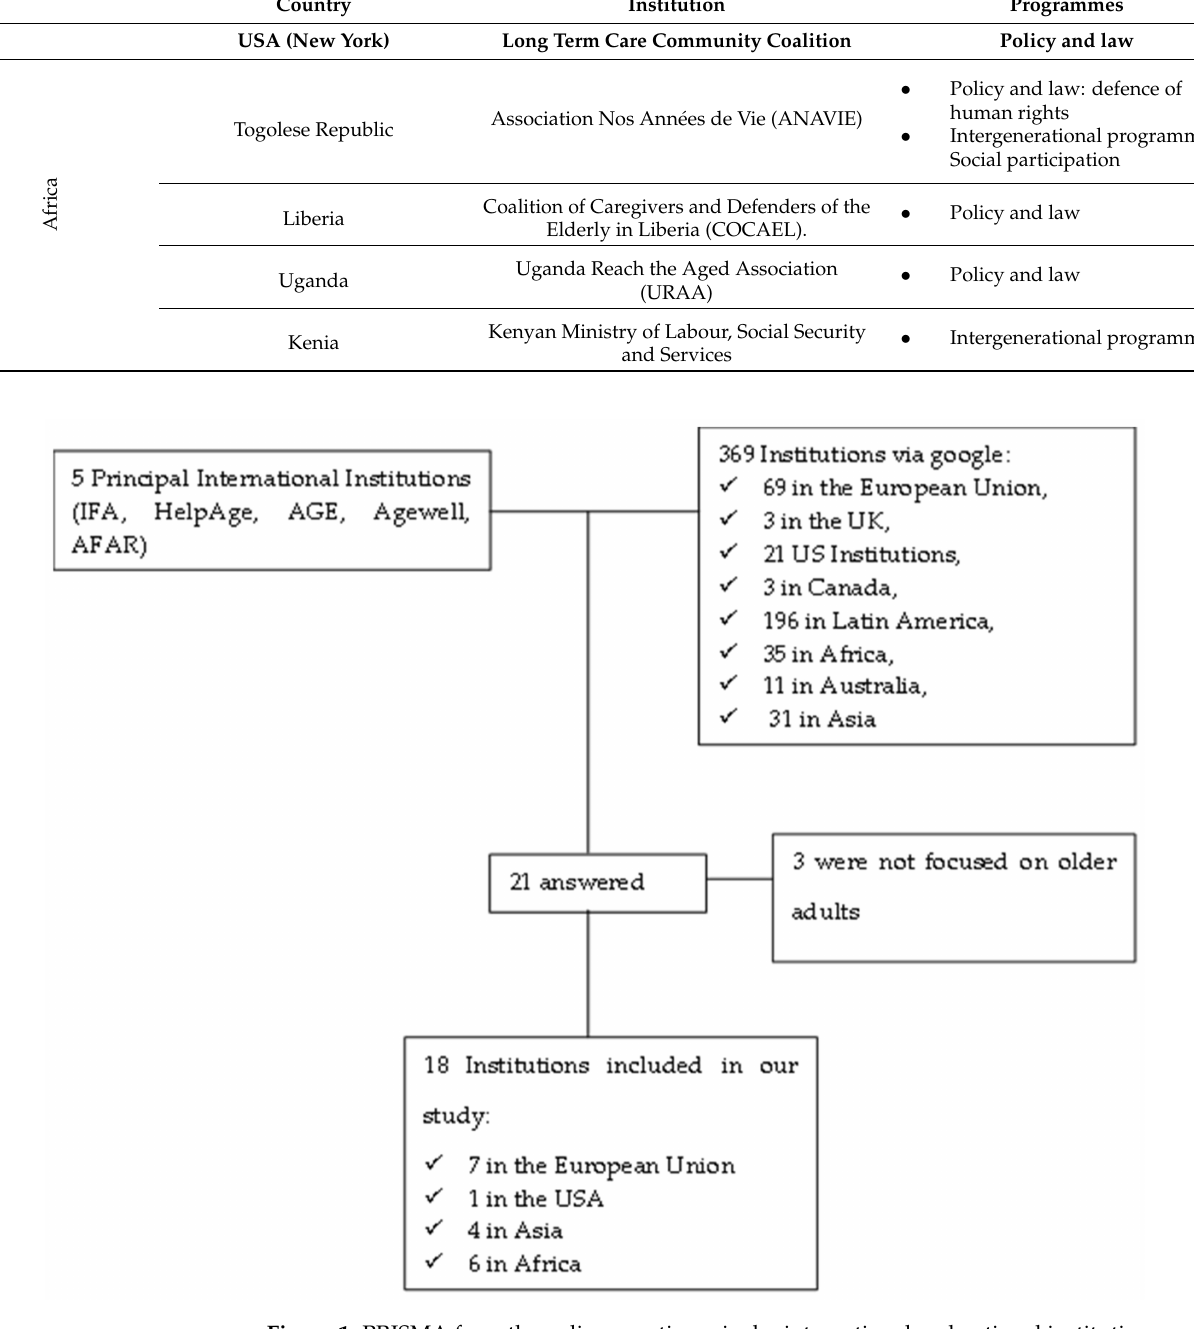
Figure 1. PRISMA from the online questionnaire by international and national